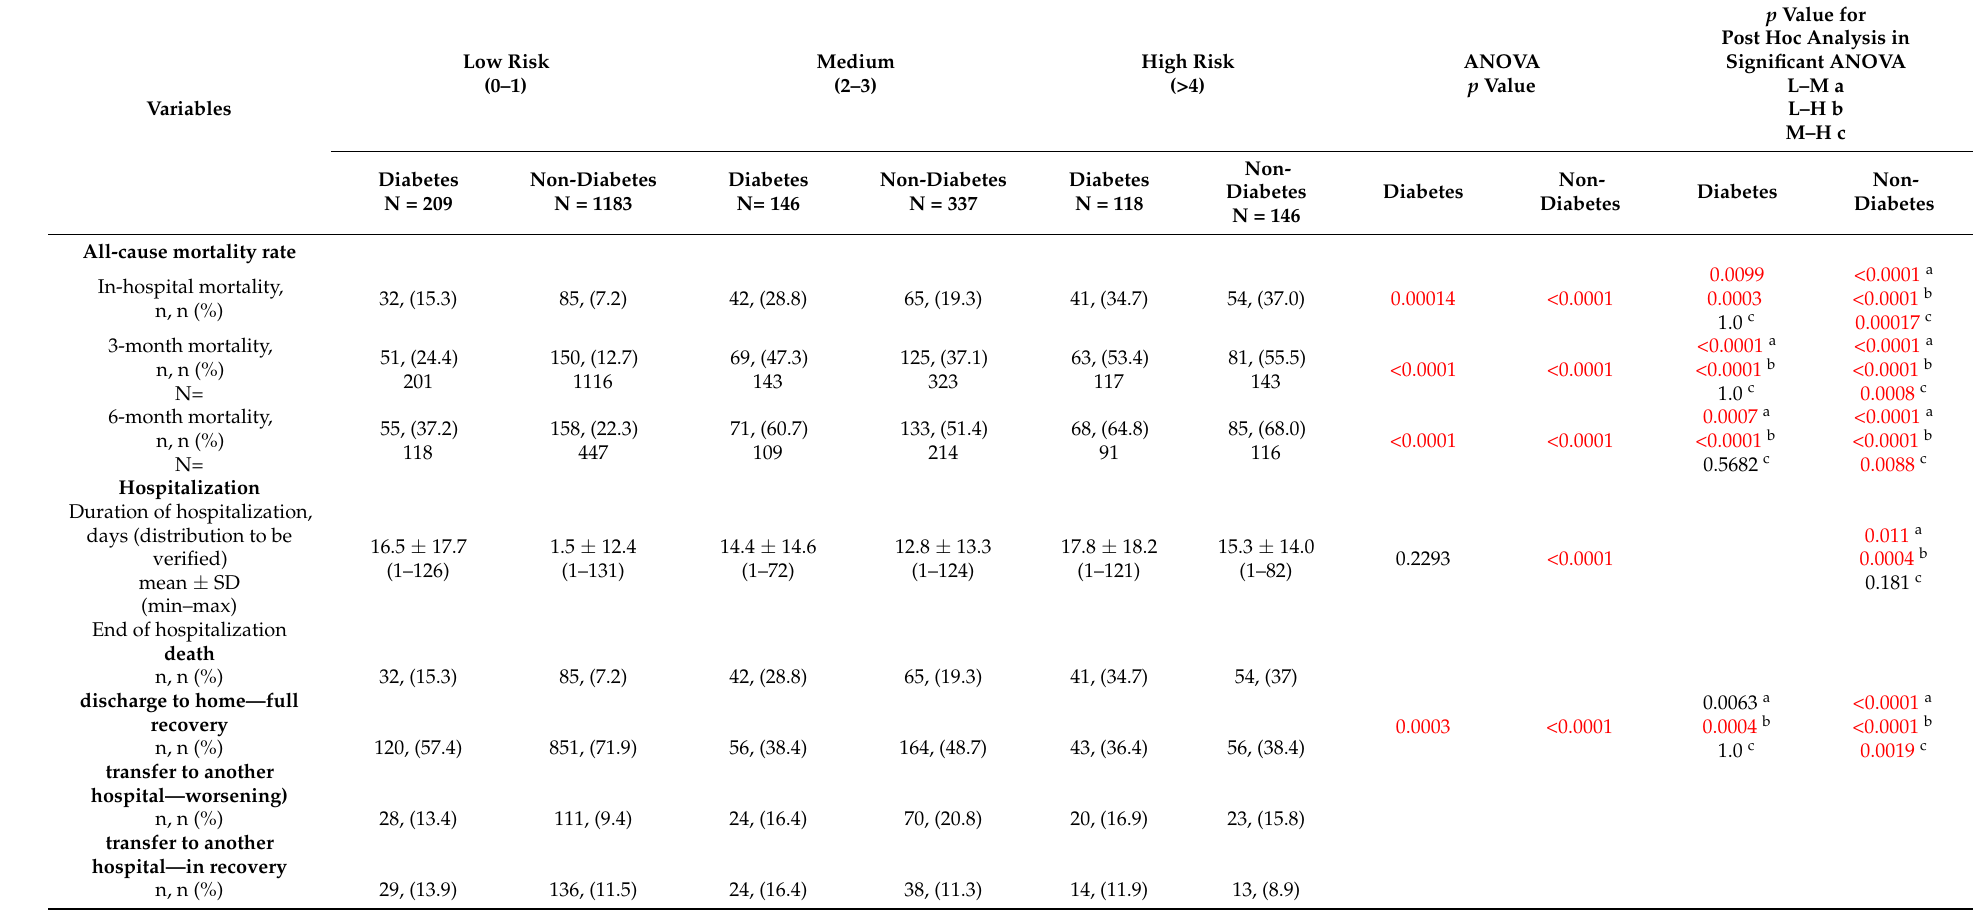
Table 4. Total and in-hospital all-cause mortality in the C 2 HEST risk strata in the diabetic and non-diabetic